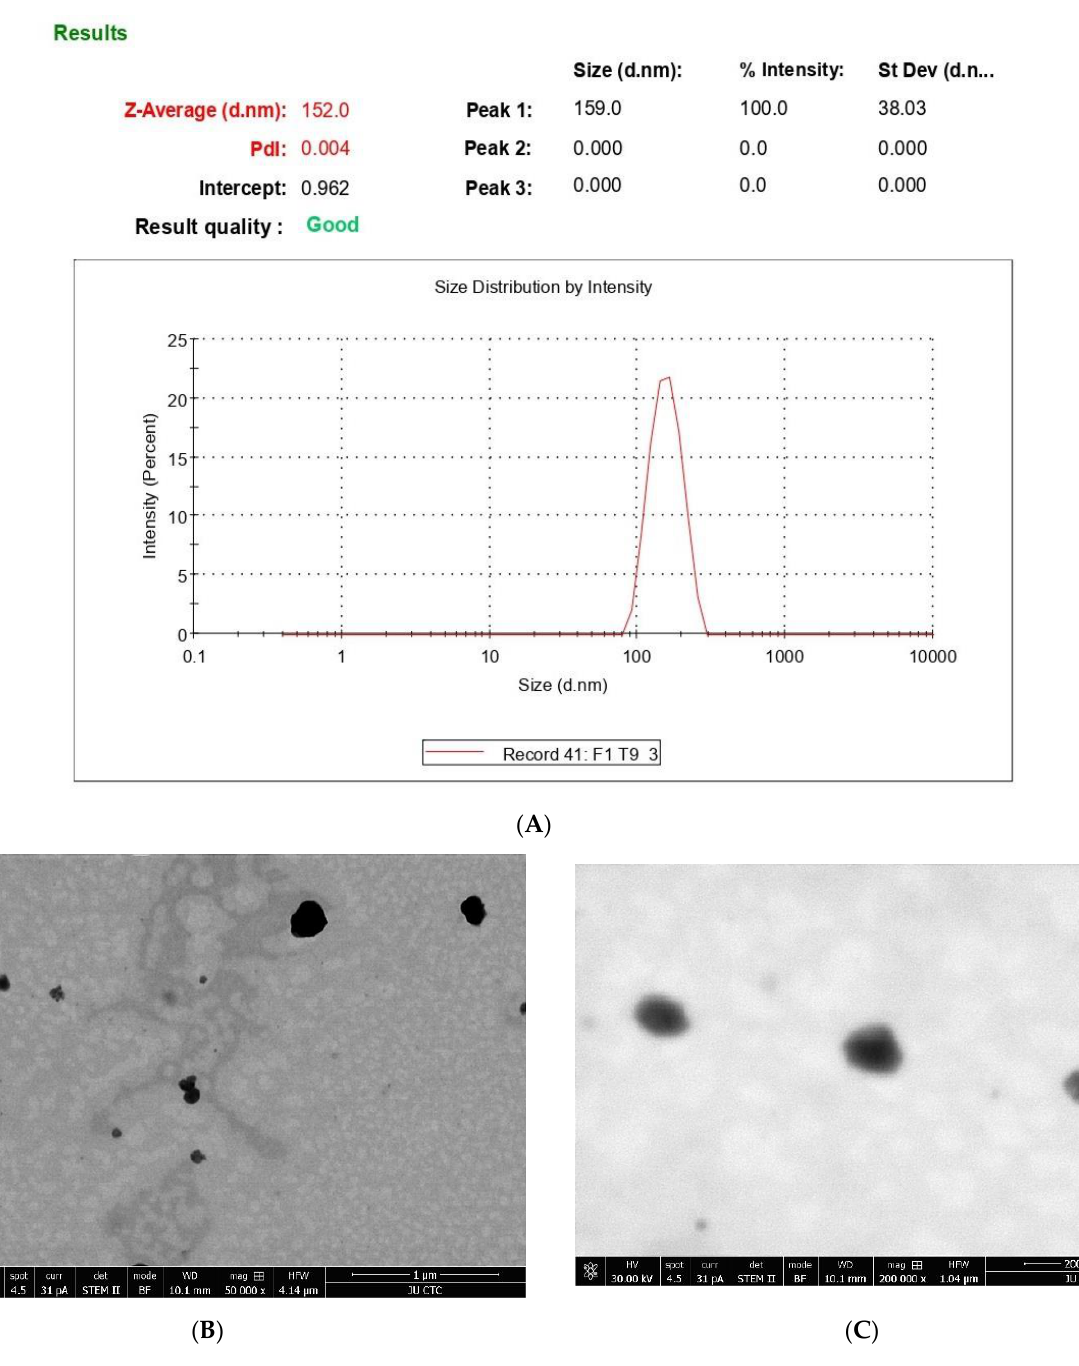
Figure 1. ( A ) Size distribution of 6-gingerol-loaded PEGylated nanophytosomes by DLS; ( B ) TEM images of shape and size of loaded PEGylated nanophytosomes; ( C ) morphology (6-gingerol-loaded PEGylated nanophytosomes).